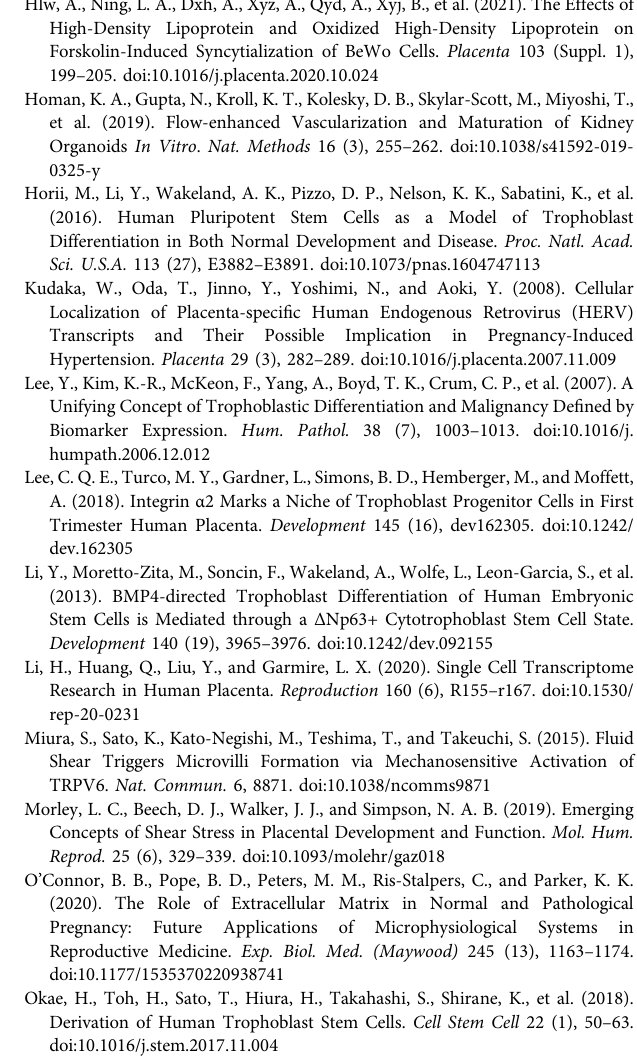
Supplementary Figure S4 | HE staining of primary placental (6 – 8 weeks), and trophoblast-like tissues under fl ow and static conditions. Scale bars, 200 μ m. SupplementaryFigureS5| Immuno fl uorescenceimagesofGLUT4introphoblast- like tissues under fl ow and static conditions. Scale bars, 20 μ m. Supplementary Figure S6 | Heatmap of altered CTB-, STB-, and EVT-related markers in placental trophoblast-like tissues derived from hiPSCs under static and dynamic conditions from RNA-seq analysis. (A) Expression of CTB-speci fi c genes GATA3,KRT7,TEAD4,ELF5,andTFAP2CwasdemonstratedinaheatmapinRNA- seq. (B) STB-related genes SDC1, CGA, CYP19A1, ERVW-1, LGAALS13, SLC1A1, PSG1, DEPDC18, ADHFE1, INHA, MUC15, GCM1, INSL4, and HSD31B were displayed in a heatmap calculated by FPKM. (C) EVT-related markers ITGA5, ITGA1, MMP11, SPON2, and PAPPA1 were demonstrated in a heatmap from RNA-seq